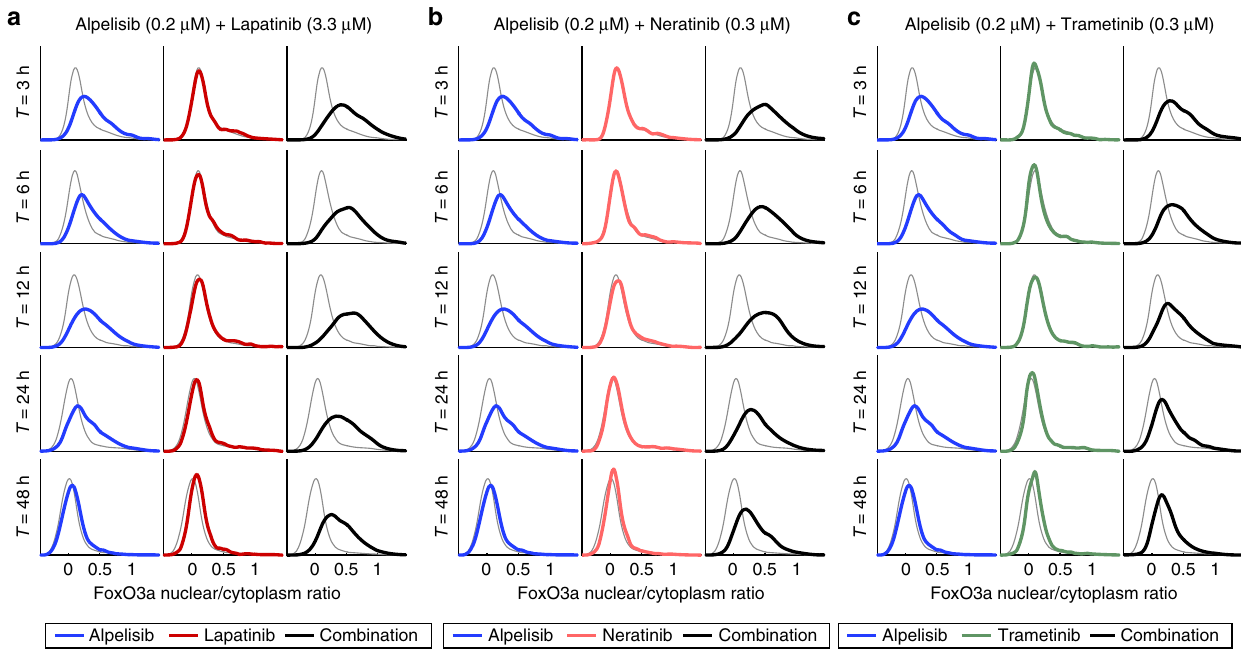
Fig. 6 Class IV drugs suppress the recovery of FoxO3a signaling. a – c Distribution of the nuclear/cytoplasmic ratio FoxO3a as measured by quantitative immuno fl uorescence microscopy at timepoints indicated. For each distribution, ~2000 cells were analyzed. Cells were treated with alpelisib in combination with either a lapatinib, b neratinib, or c trametinib at the concentrations shown. Gray line show untreated control, blue alpelisib, red the EGFR or MEK inhibitor, and black the combination treatment. Data shown is one out of three biological middle and right, Supplementary Fig. 4a middle and right, Supplementary Fig. 4b). For example, the GR EOB for alpelisib plus lapatinib or neratinib at the concentrations used in Fig. 5a is 0.64 ± 0.12 and 0.65 ± 0.12 respectively ( p < 0.05, t -test based on GR